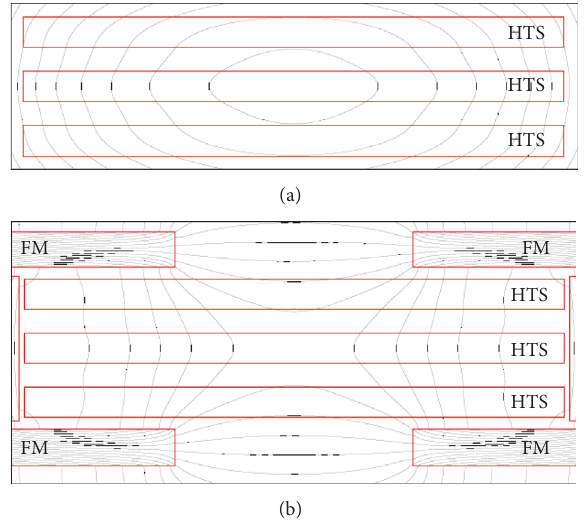
Figure 9: Calculated magnetic flux lines by finite element method ANSYS code [9] for three-layer stacked tape conductors (a) without FMs and (b) with FMs at the edges under the same-direction ( ↑↑↑ ) current feeding mode. The currents in each tape are 𝐼 1 = 𝐼 2 = 𝐼 3 = 200 A as in Figure 3(a).